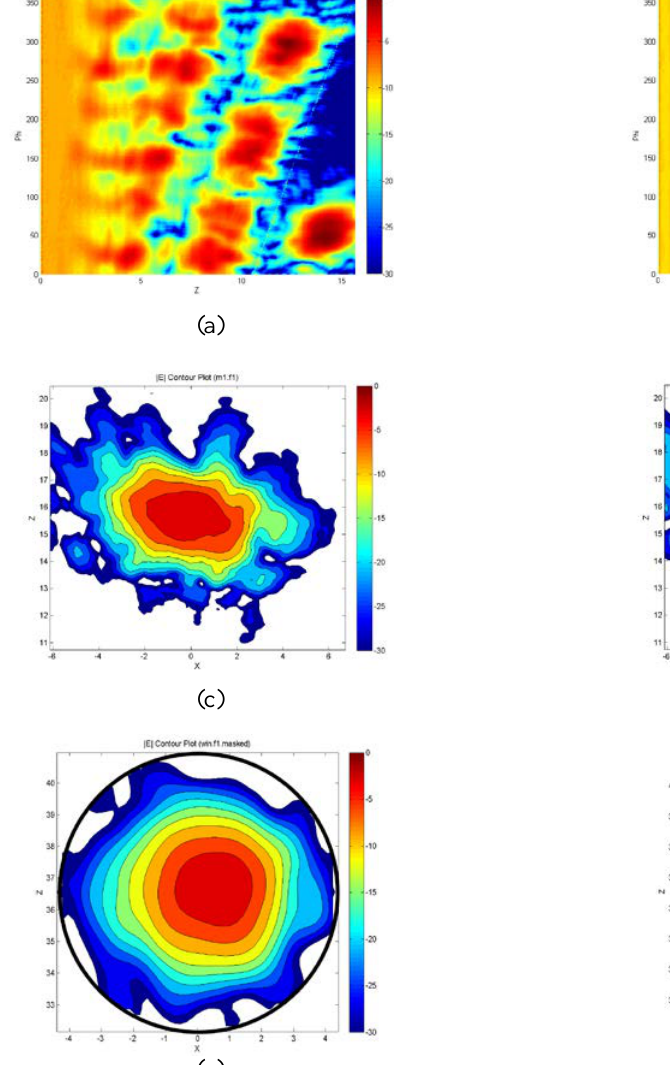
Fig. 2. A schematic of the VGT-8141A gyrotron .